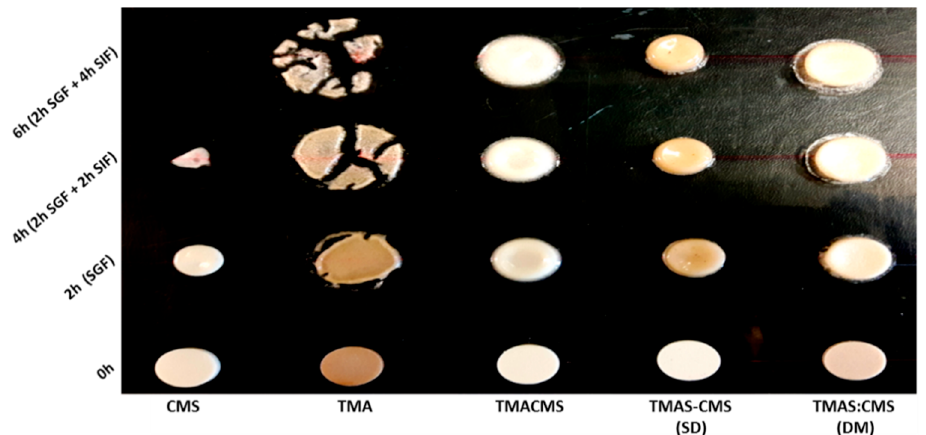
Figure 5. Photographs of placebo tablets of CMS, TMAS, TMACMS, TMAS-CMS (SD), and